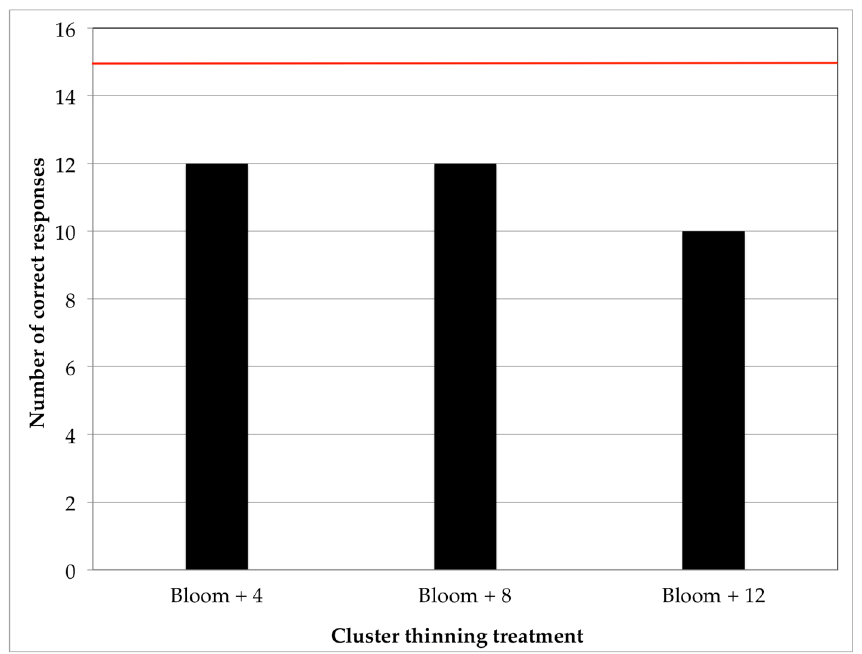
Figure 1. Results of the duo-trio test with constant reference performed in the 2016 wines. Each cluster thinning treatment was contrasted against the control treatment. A total of 15 correct responses were needed for a statistically distinguishable sensory difference ( p < 0.05). The horizontal red line indicates the number of correct responses required to attain statistical significance.